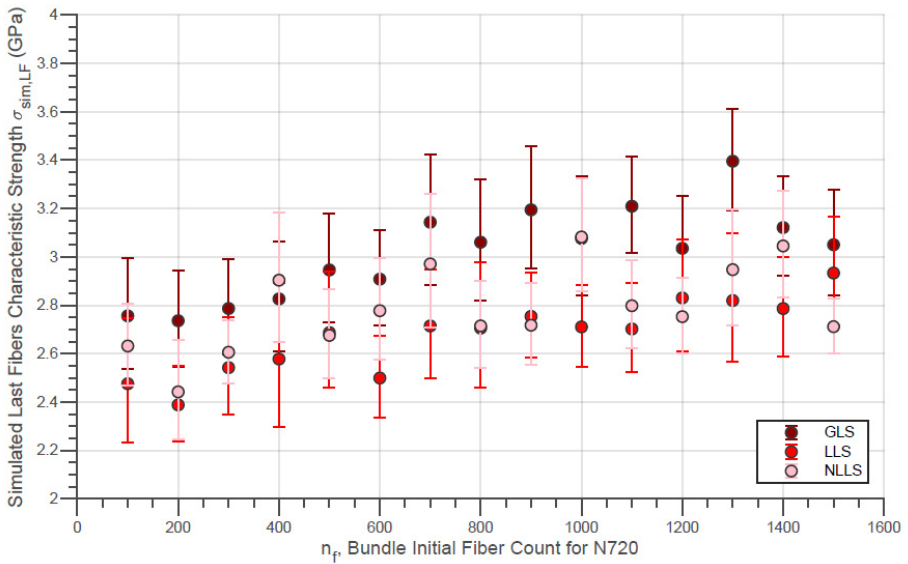
Figure 15. Simulated Characteristic Strength of the Last Fibers Within the Bundle against Initial Fiber Count for N610 Fiber Bundles using different load-sharing models.